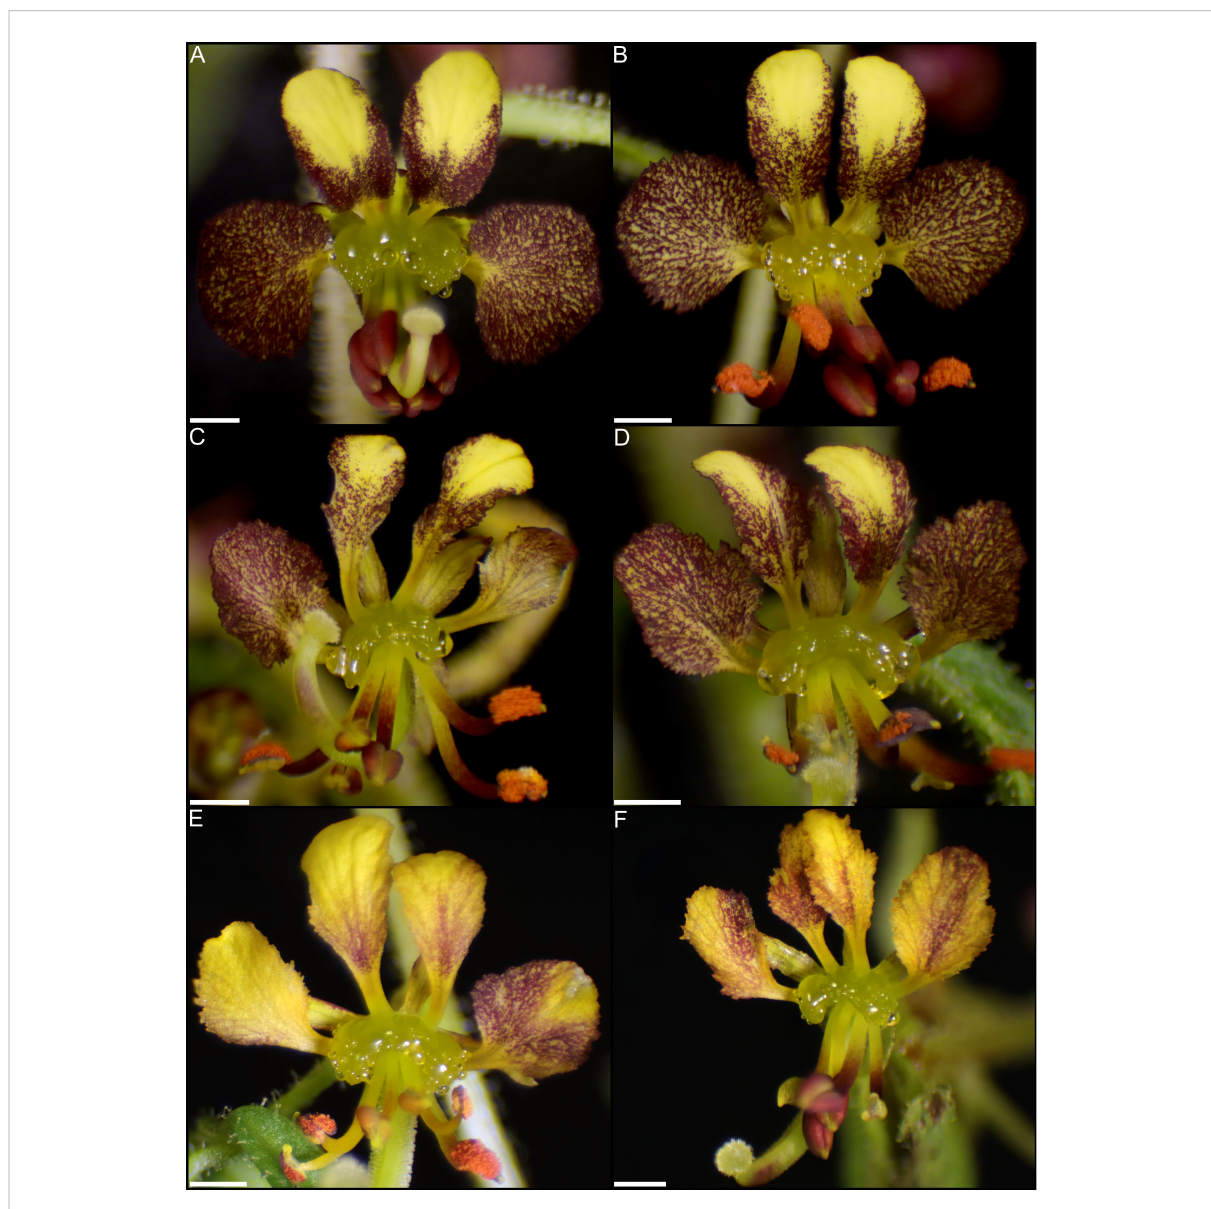
FIGURE 8 Cleome violacea fl owers from untreated and treatment control groups. (A) Untreated newly anthetic fl ower and (B) maturing fl ower. pTRV2- MCS treated fl ower displaying (C) moderate and (D) mild viral phenotype. (E, F) pTRV2- CvANS treated fl owers displaying moderate yellowing petal phenotypes. Scale bars = 1